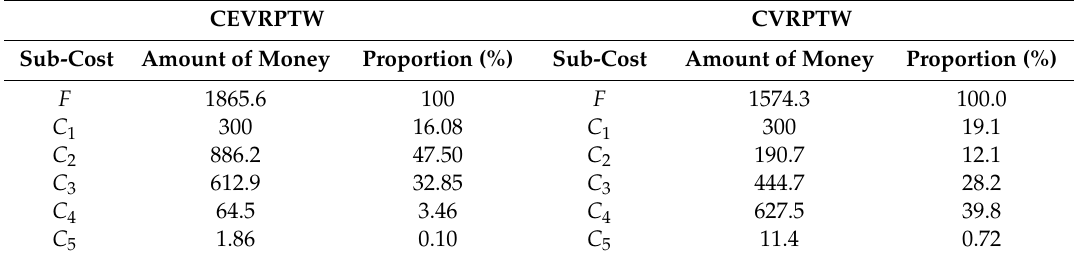
Table 9. The proportion of the cost when carbon price is 0.05.